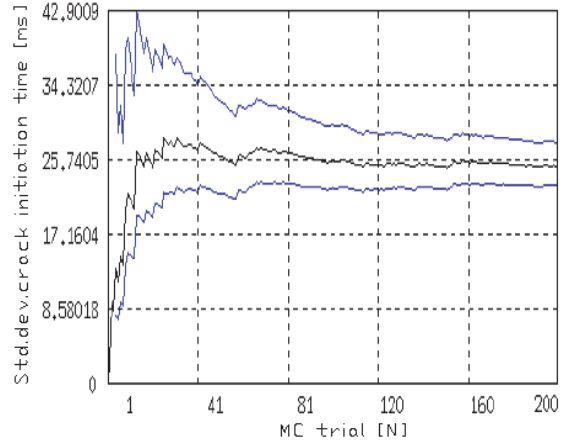
Figure 11: Std dev. of the crack init. time [ms] vs. MC